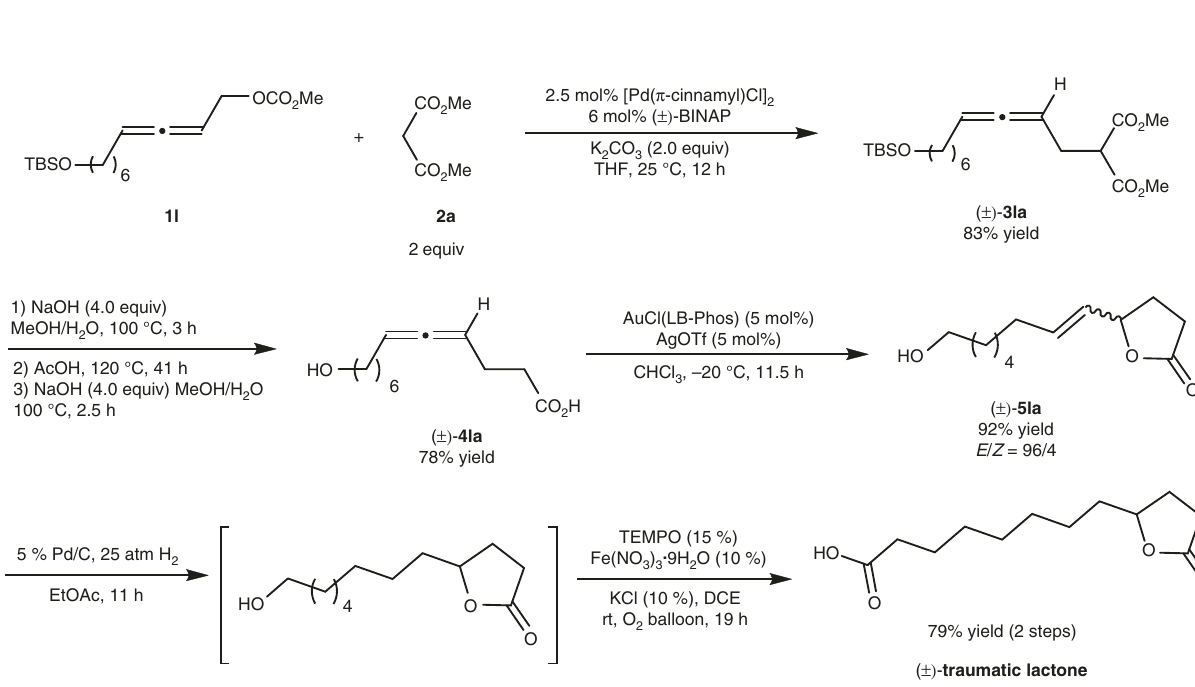
Fig. 3 The synthesis of (±)-traumatic lactone. Details of reagents, catalysts, solvent, and temperature are given in the reaction